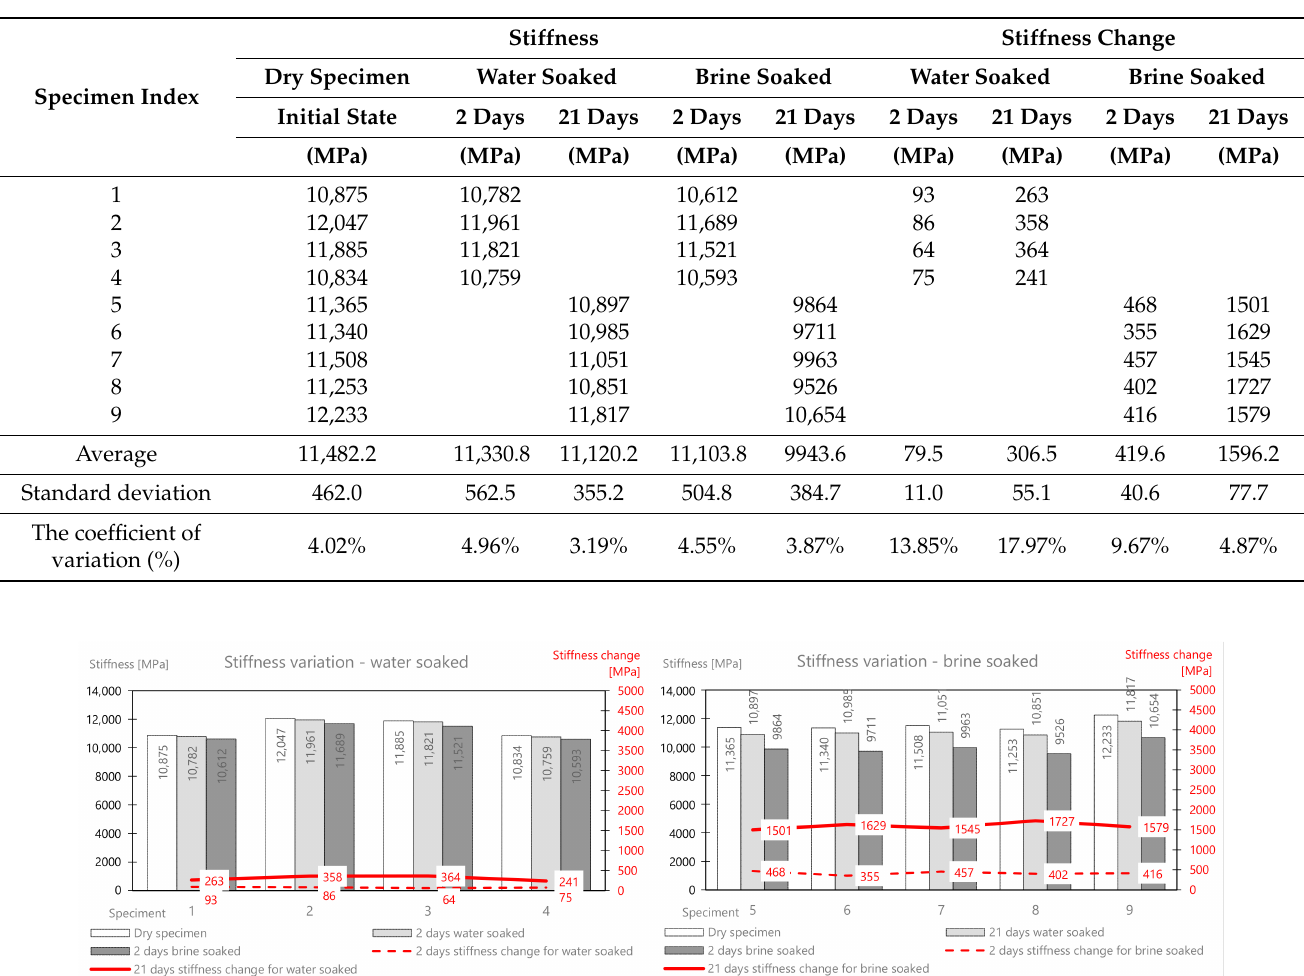
Table 8. AC22WMS(HIMA) mix stiffness variation via water and brine soaking.